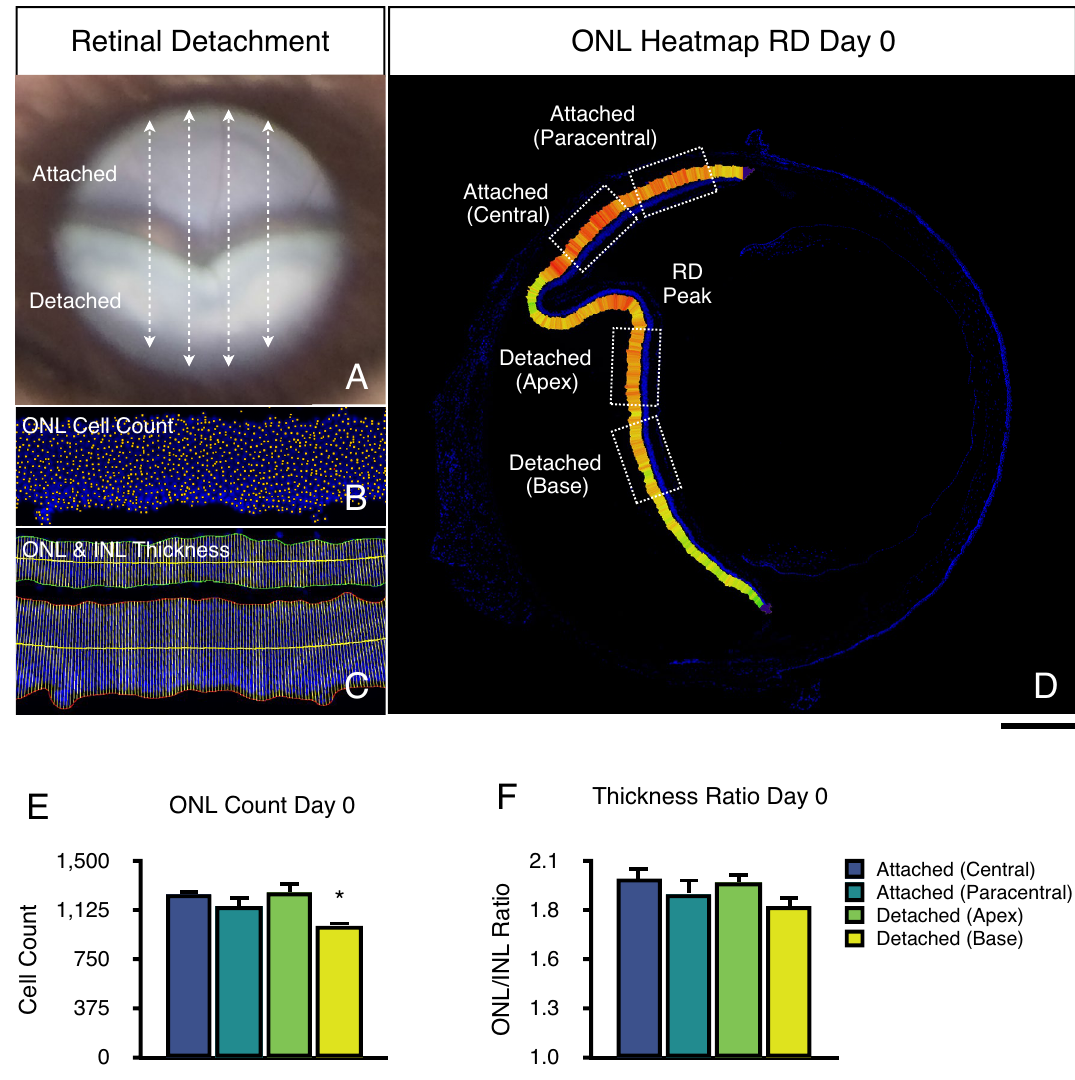
Figure 1. Retinal detachment changes immediately after retinal detachment (baseline, day 0). ( A ) Representative fundus photo of a murine retinal detachment (RD) and sectioning planes (dashed arrows). ( B ) Cryosection image of a 400 µm ONL segment for ONL Cell Count at baseline analysis. ( C ) Cryosection image of a 400 µm ONL segment for outer (ONL) and inner nuclear layer (INL) thickness measurement. ( D ) Representative cryosection whole-retina tile image of a retinal detachment relative ONL thickness heatmap. Regions of interest used for analysis (dotted boxes). ( E ) ONL cell count analysis. ( F ) ONL/INL thickness ratio analysis. Scale bar = 400 µm ( D ). * p < 0.05 vs. attached central region (n =